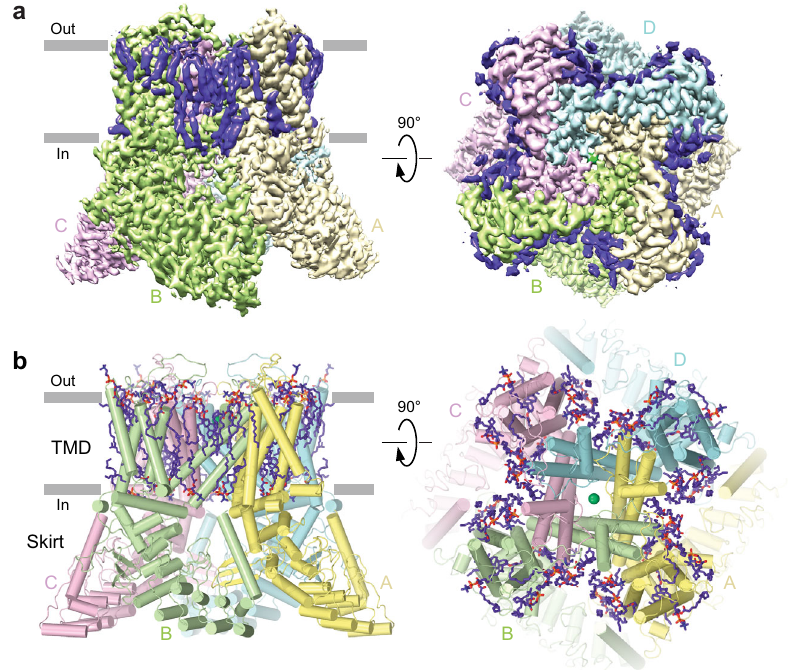
Fig. 1 Structure of TRPV6 in the open (apo) state. a Cryo-EM density for TRPV6 Open , with individual subunits shown in yellow, green, pink, and blue, and lipids in purple. b Model of TRPV6 Open , with lipids shown as sticks and calcium ion as a green